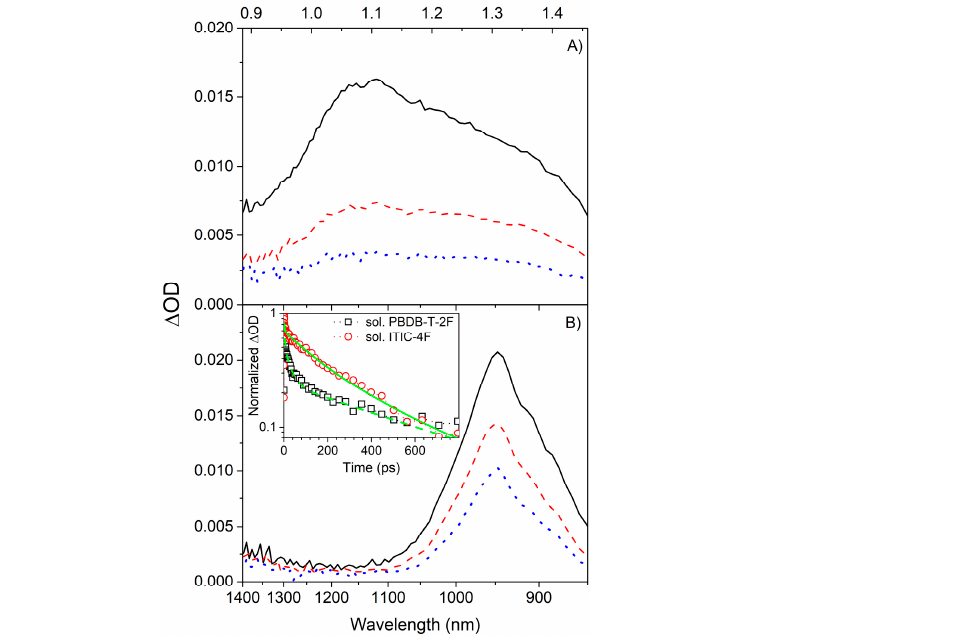
Figure 3. Δ OD spectra measured with solutions of ( A ) P and ( B ) I , at an excitation wavelength of 575 nm, and extracted at various delay times of about 0 ps (solid line), 10 ps (dashed line), and 100 ps (dotted line) with decreasing Δ OD amplitude. In the inset of (B), two kinetic traces of P (open rectangles) and ( B ) I (open circles) selected at the maximum wavelengths are shown with multi-exponential fitting curves. Table 2. Dominant spectroscopic lifetimes in picosecond time